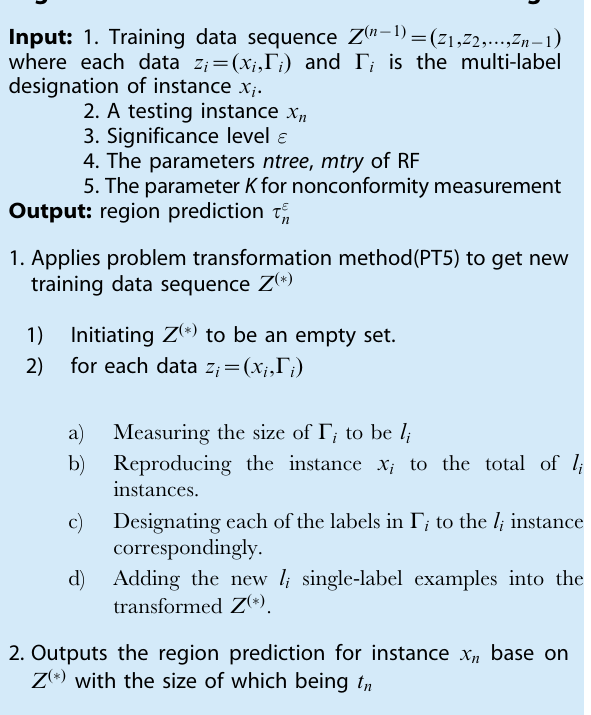
Algorithm 1: CP-RF for Multi-Label